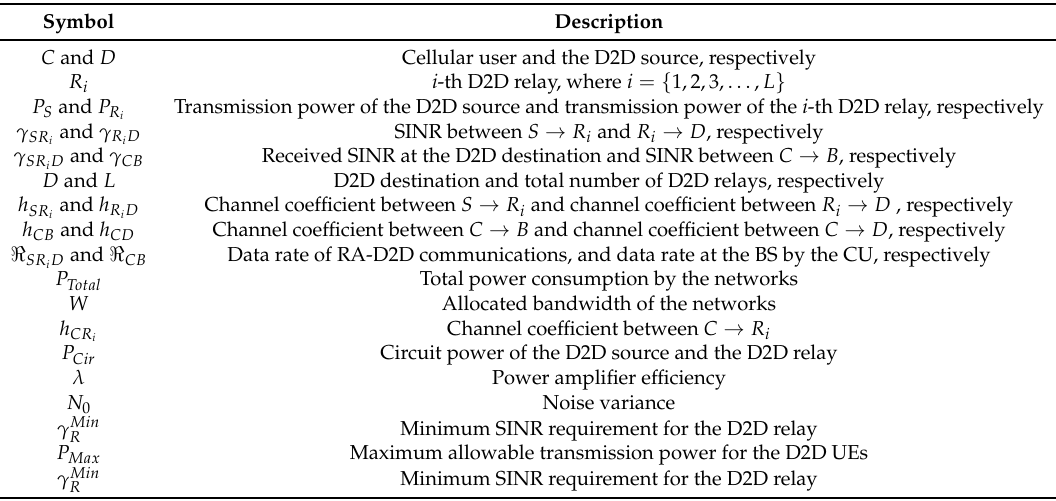
Figure 2. Frame structure of the proposed scheme. Table 1. Summary of main